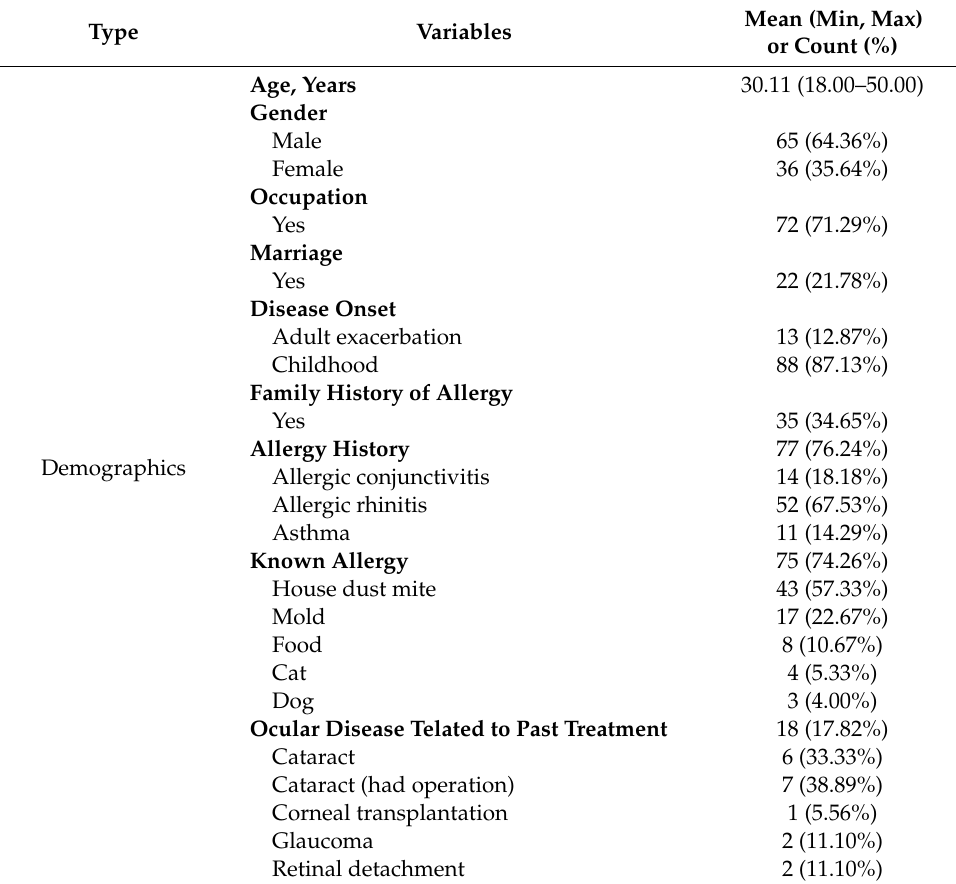
Table 1. Baseline demographics and history of treatment ( N =